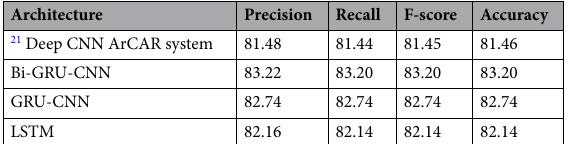
Table 7. Comparison of Bi-GRU-CNN performance and the related literature on the BRAD dataset.